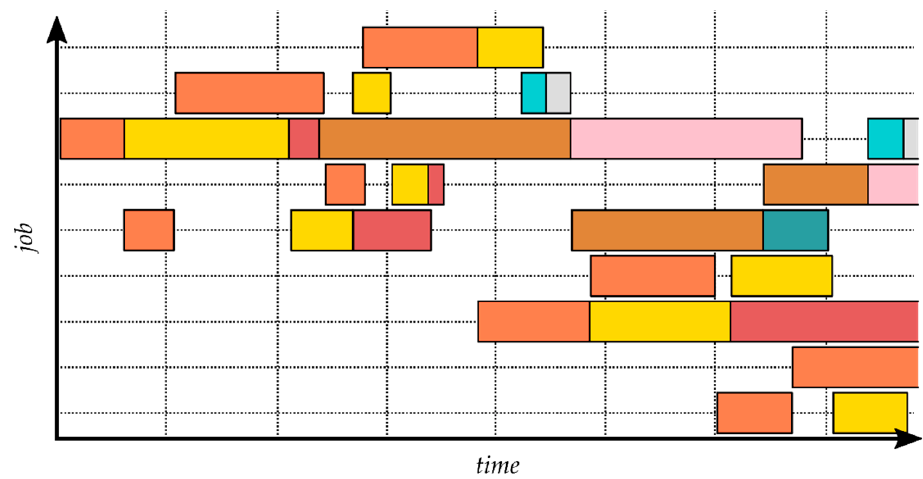
Figure 6. Optimized production schedule for the use-case.